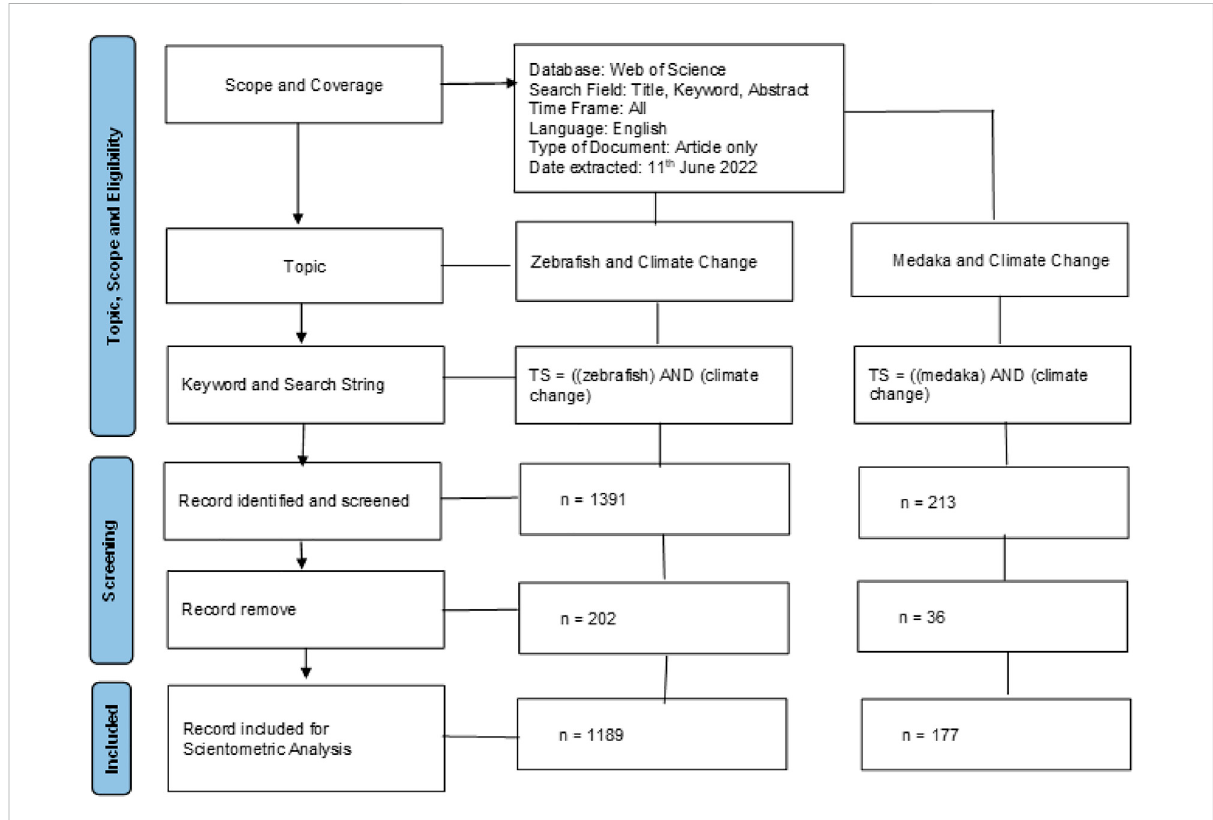
FIGURE 1 Flowchartindicatingmethodologicalframeworkwheretwoseparatesearchesweredonefocusingon:(i)Zebra fi shand(ii)Medakarelationwith climate change.